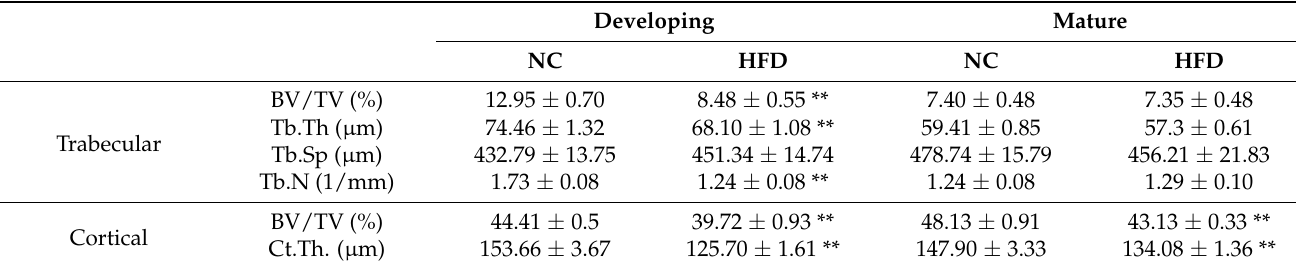
NC = normal chow; HFD = high fat diet; BV/TV = bone volume/total volume; Tb.Th = trabecular thickness; Tb.Sp = trabecular separation; Tb.N = trabecular number; Ct.Th = cortical thickness. Data are presented as the mean ± SEM ( n = 6–8 per group), ** represents p < 0.01, (2-way ANOVA followed by Bonferroni post-hoc analysis comparing diet within age groups).